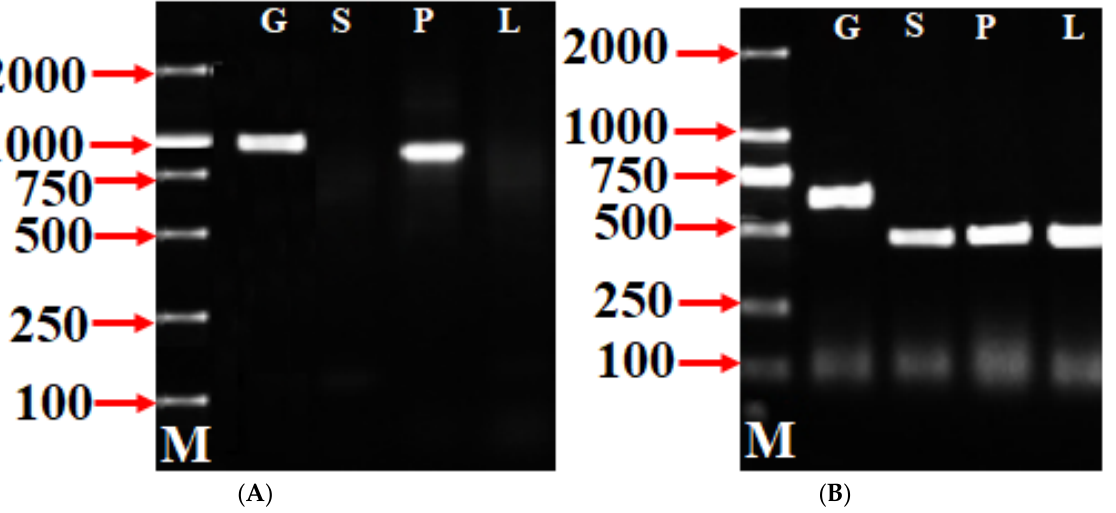
Figure 2. PmSFB ( A ) and actin gene ( B ) expression analysis in pollen (P), styles (S), and leaves (L), respectively, of ‘Sichuanbaimei’. Lane G = genomic DNA; lane M = 2 kb DNA marker. The actin gene was used as positive control.